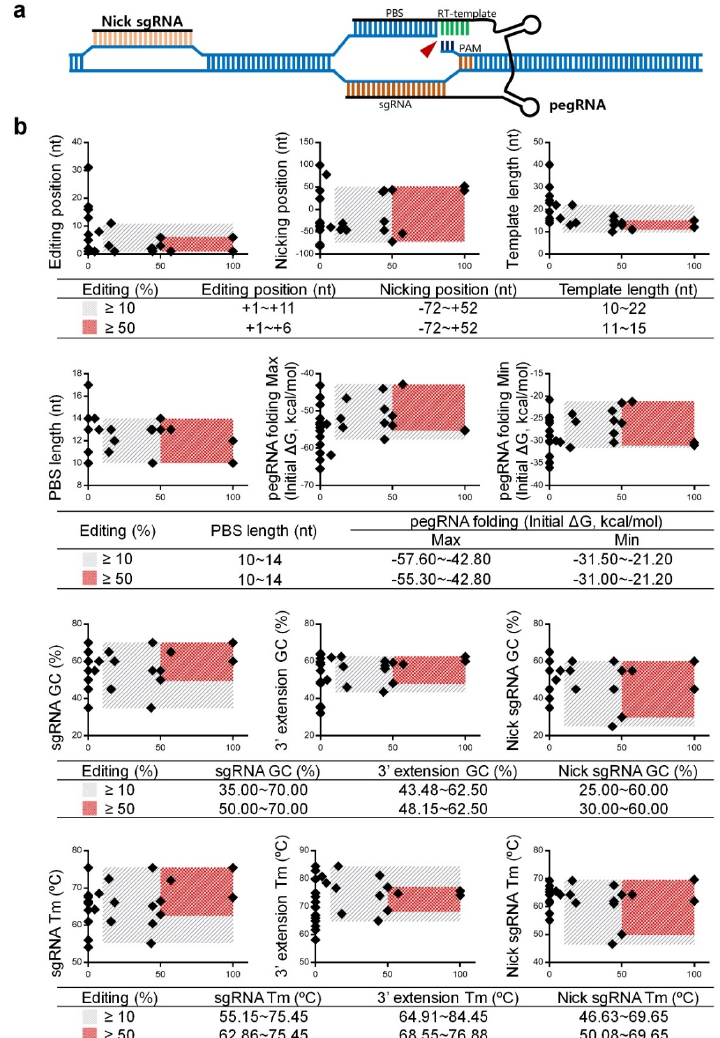
Figure 2. Data analysis of pegRNAs and nick sgRNAs. ( a ) Scheme of a PE3 construct. pegRNA combines a spacer sequence targeting the editing site and a 3 ′ extension sequence containing a primer binding sequence (PBS) fused to an RT-template with desired edits of interest. A nick sgRNA targets the non-edited strand for nicking, further increasing editing efficiency. ( b ) In this study, 26 different PE3 formulas were designed to induce beta-thal mutations. The x -axis indicates the editing ratio, whereas the y -axis indicates each detail of the PE3 formula, including editing position, nicking position, template length, PBS length, pegRNA folding energy, GC contents, and T m values. The gray slash block indicates that the editing ratio is ≥ 10%, whereas the red dot matrix block indicates that the editing ratio is ≥ 50%.